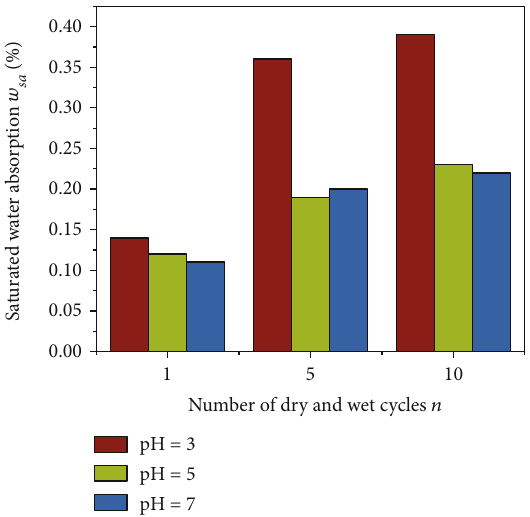
Figure 7: The relationship between saturated water absorption rate and the number of dry-wet cycles.